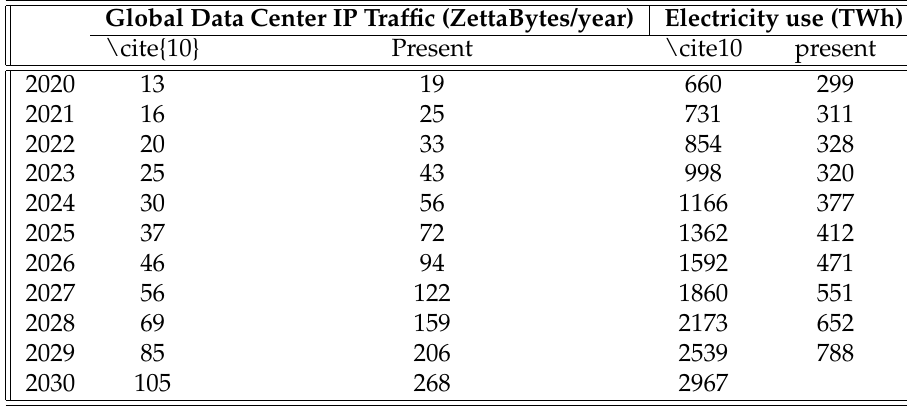
Table 1. Differences between [3] expected case and the present prediction for data